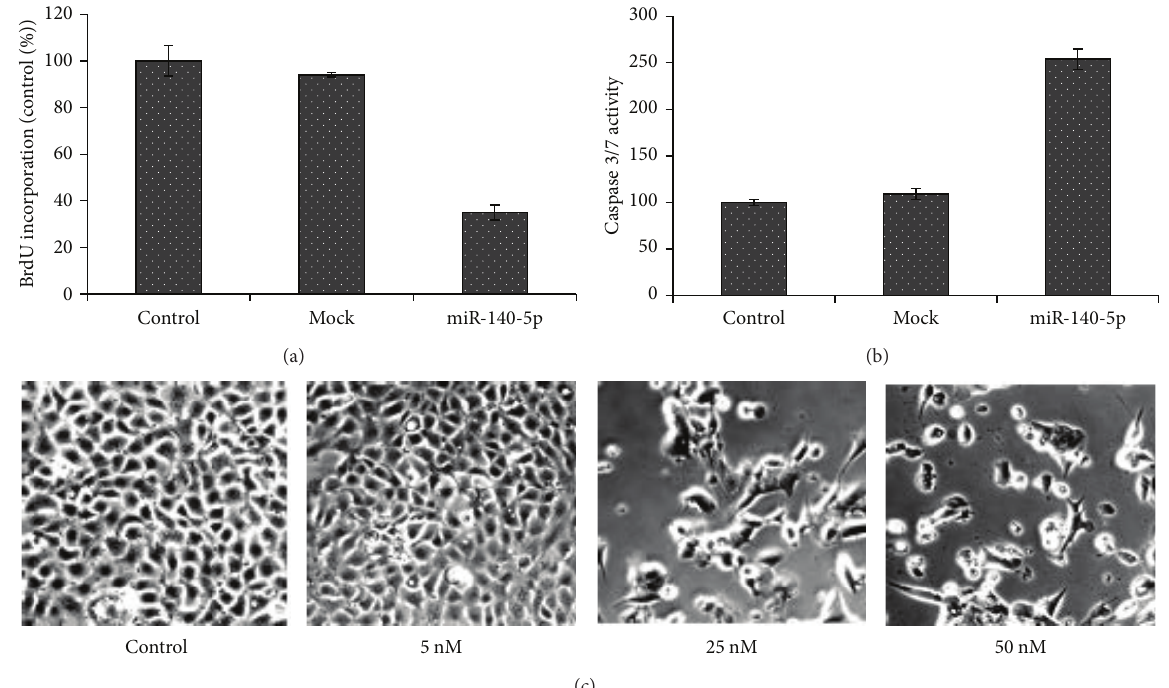
Figure 5: Antiproliferative effects of miR-140-5p on DNA synthesis (a) and caspase 3/7 activity (b). The miR-140-5p transfected cells were incubated with BrdU, followed by BrdU incorporation that was measured. Caspase 3/7 activity was measured as per the manufacturer’s instruction. Values are expressed as mean ± SD from three independent experiments. Light microscopic photomicrographs of EC9706 cells after exposure to different concentration of miR-140-5p